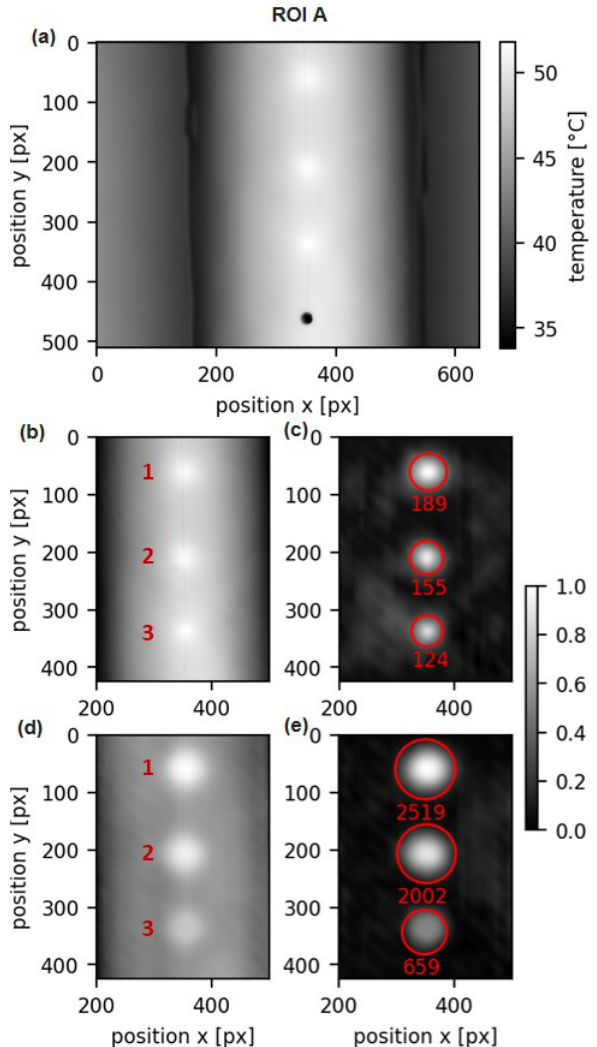
Figure 6. Results of test series 1 (ROI A, t exc = 25s, t rec = 15s, k = 89mm, ( a ) surface temperature of the whole camera FOV, ( b ) result for the reference method without filtering at t rec = 0s, ( c ) reference image with filtering, automatic defect detection and calculation of the CNR, ( d ) result for the PCA- based method without filtering, ( e ) PCA-based image with filtering, automatic defect detection and calculation of the